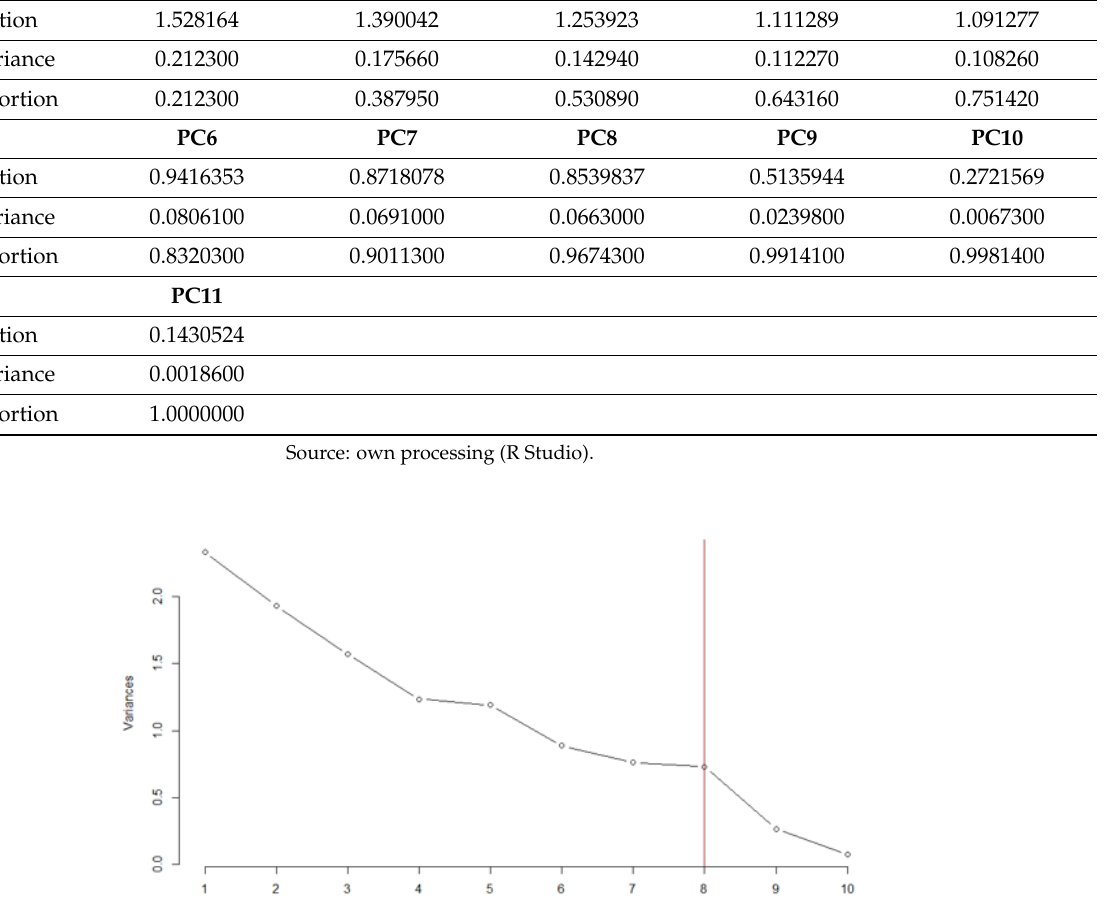
Figure 3. The screenplot of the main components. Source: own processing (R Studio). Another approach was to select the number of enterprise clusters in this analysis.